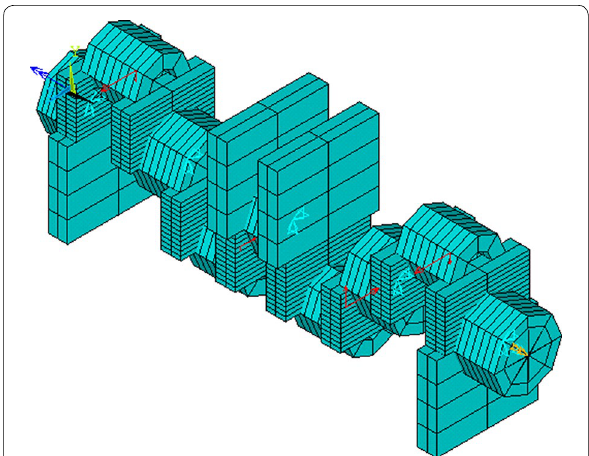
Figure 2 Beam-element finite element model of whole crankshaft